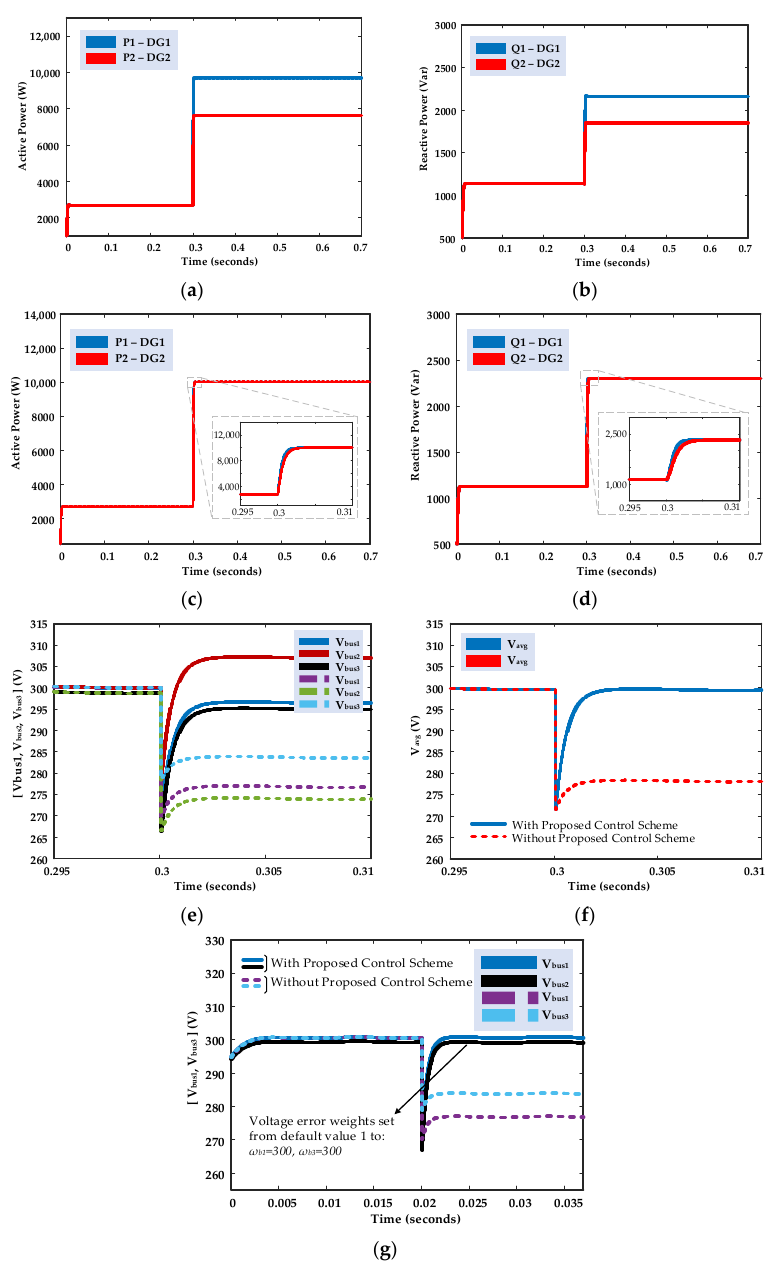
Figure 10. Simulation results. ( a ) Active power response without proposed control scheme. ( b ) Re- active power response without proposed control scheme. ( c ) Proportional active power sharing proposed control scheme. ( d ) Proportional reactive power sharing with proposed control scheme. ( e ) Load buses V bus1 , V bus2 and V bus3 response curve. ( f ) Average load bus voltage curve of V bus1 , V bus2 and V bus3 ( g ) V bus1 and V bus3 voltage curve by weight ( ω b1 , ω b2 ) variation from 1 to